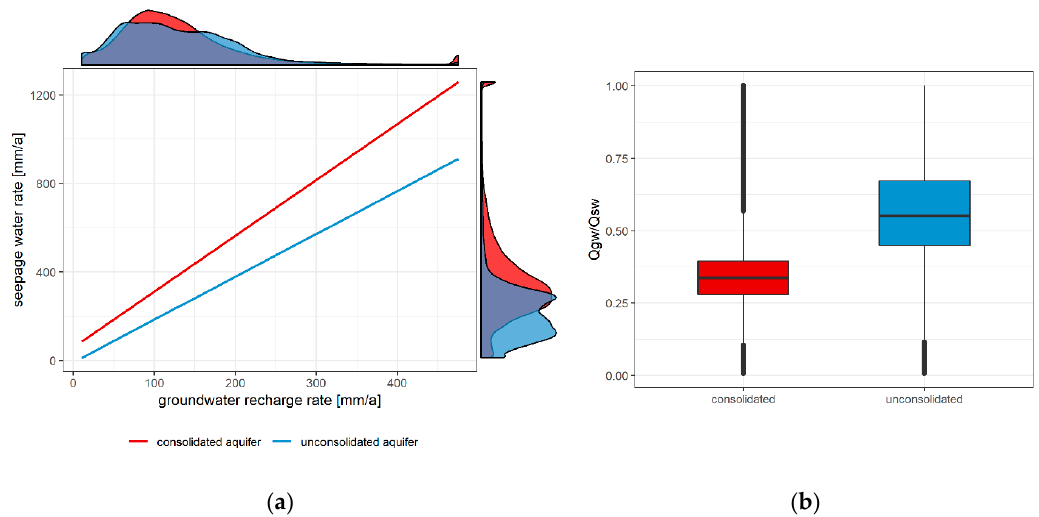
Figure 2. ( a ) Combined regression and density plot of the seepage water [37] and groundwater recharge rate [38]; ( b ) boxplot of the ratio of the groundwater recharge and seepage water rate grouped by the consolidated and unconsolidated aquifers.